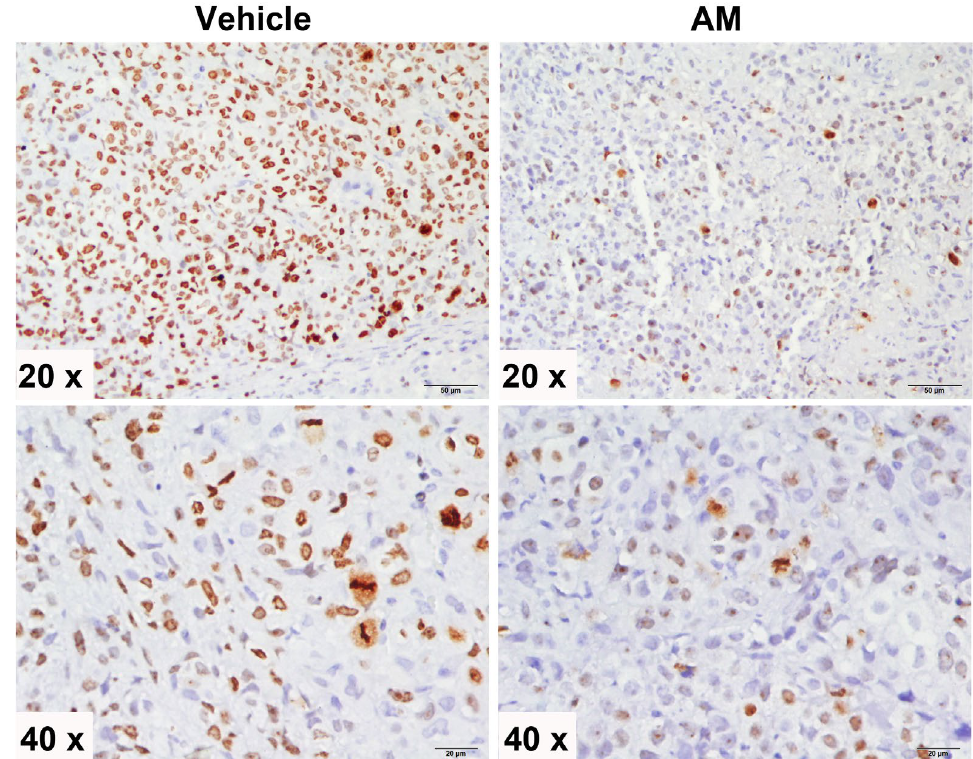
Figure 6. Immunohistochemical analysis of Ki-67 in the tumor tissue of vehicle and AM-treated mice. SiHa cervical cancer cells were subcutaneously xenografted into the lower limb of each mouse. Mice were randomly divided into two groups: vehicle-treated and α -mangostin (AM) -treated. After four weeks of treatment, the mice were euthanized and the tumor tissue was collected and fixed in formaldehyde for immunohistochemical staining. The proliferation marker Ki-67 was expressed in a lesser degree and by fewer tumoral cells of mice treated with AM for 4 weeks, as compared to controls. Representative 20× and 40× magnification photographs are shown for each group.